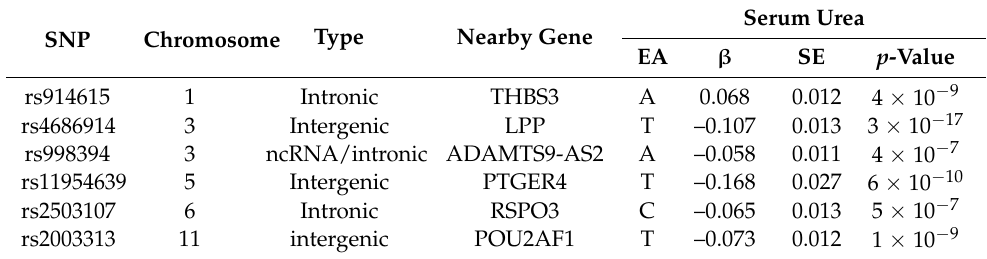
Table 2. Characteristics of SNPs for serum urea